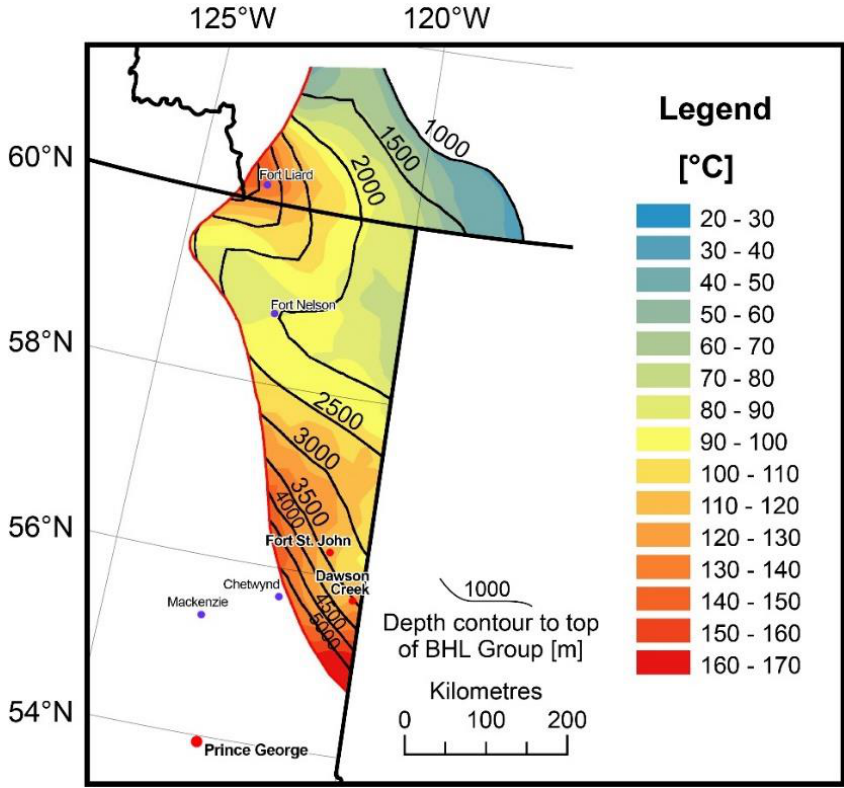
Figure A9. Temperatures top of BHL Group—NE British Columbia S. NWT WCSB.